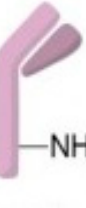
Figure 3. Trastuzumab.